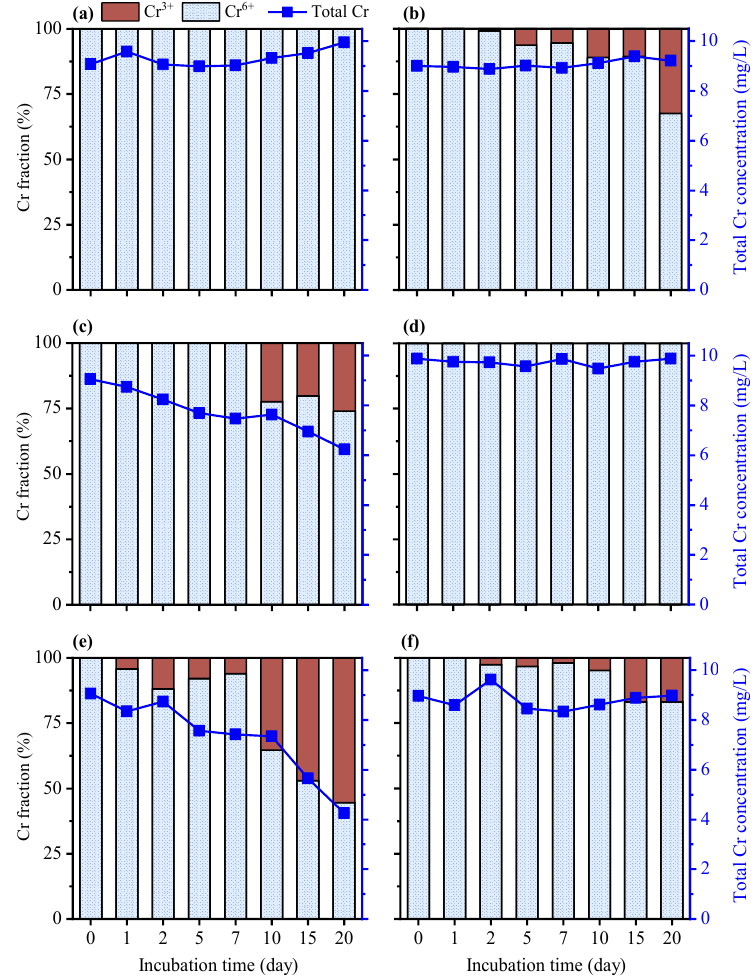
Figure 1. Total chromium, Cr(VI) and Cr(III) concentrations in different experimental groups during 20 days’ incubation: ( a ) Cr, ( b ) Cr + PA, ( c ) Cr + Fe-300, ( d ) Cr + Fe-800, ( e ) Cr + Fe-300 + PA and ( f ) Cr + Fe-800 + PA. Water 2023 , 15 , x FOR PEER REVIEW